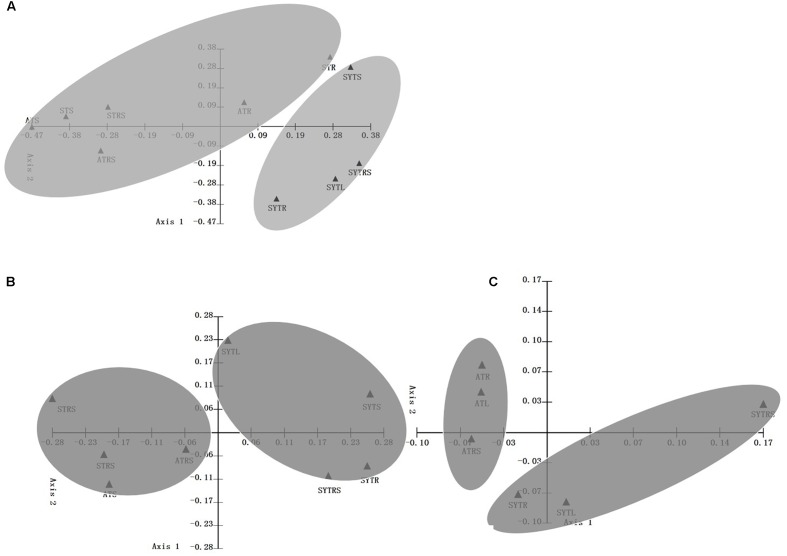
Principal coordinate analysis (PCoA) with a weighted UniFrac algorithm using archaeal and bacterial amoA gene sequences recovered from the seagrass T. hemprichii in coral reef ecosystems. Shown are the plots of the first two principal coordinate axes for PCoA and the distribution of AOA (A: DNA level) and AOB (B: DNA level; C: transcript level) (designated with the sampling station names) communities in response to these axes.